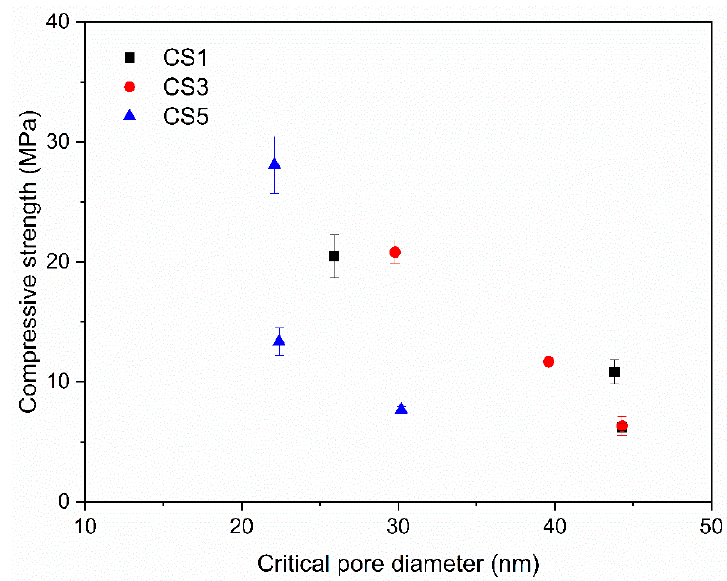
Figure 16. Relationship of compressive strength of slag blended pastes with critical pore size at 3, 7 and 28 days.